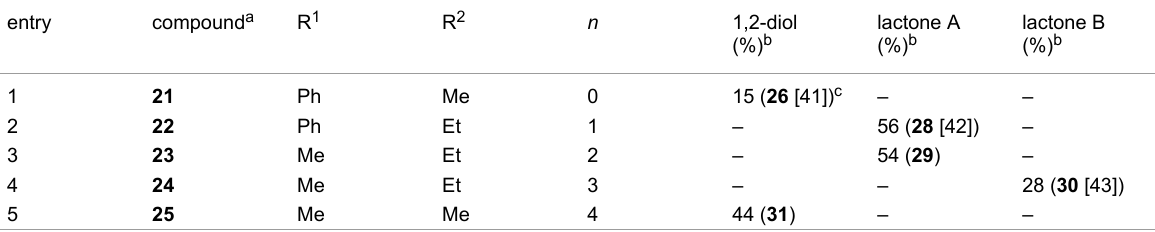
Table 3: Photohydroxymethylation of keto esters: 1,2-diol and lactone